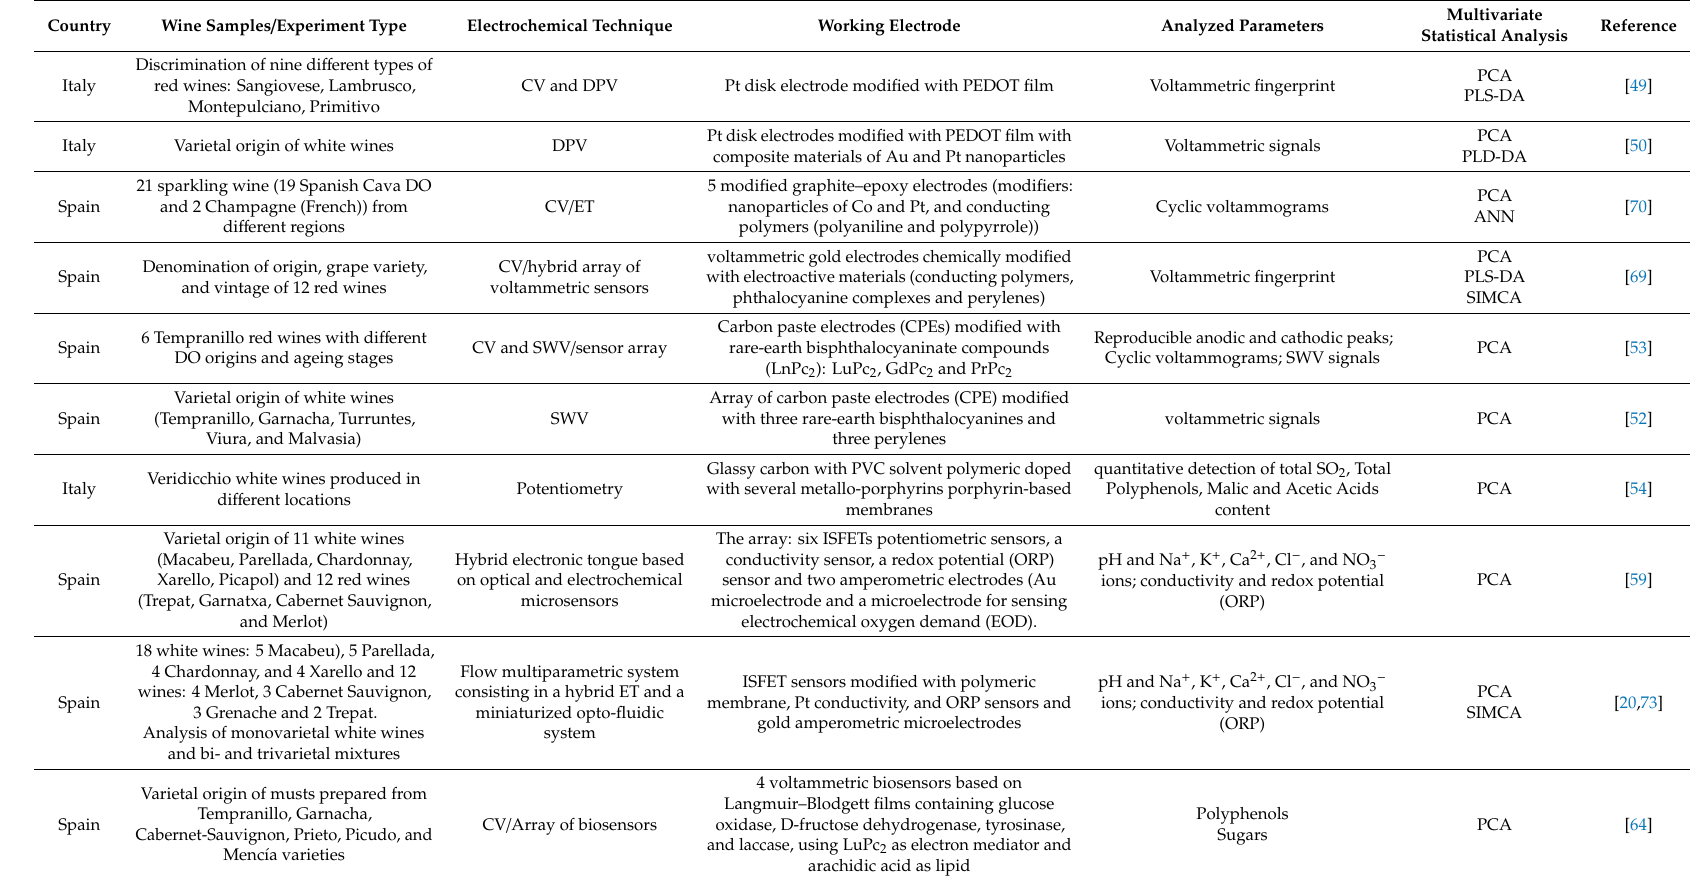
Table 1. Discrimination of varietal and geographical